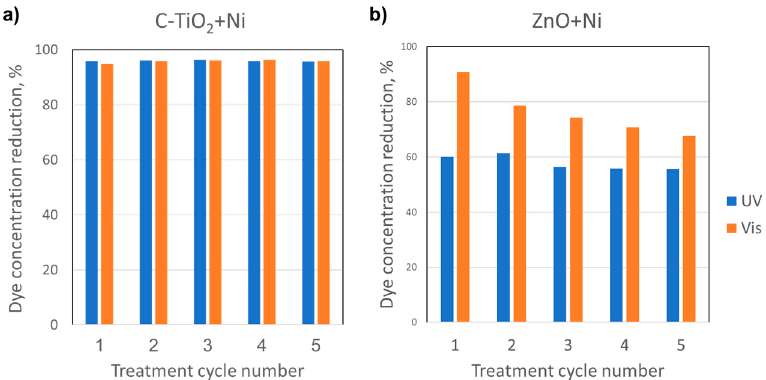
Figure 5. Repetitive photocatalytic bleaching of Methylene blue solution under UV light and Rhodamine B solution under Vis light irradiation: ( a ) bleaching using C-TiO 2 +Ni photocatalyst, ( b ) bleaching using ZnO+Ni